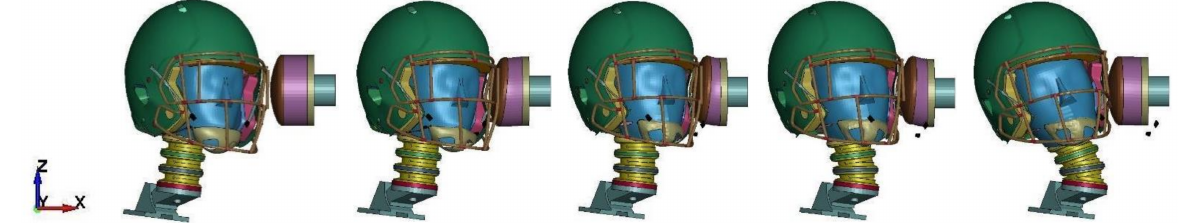
Figure A4. Course of simulation (0–20 ms, 5 ms interval) in configuration B.